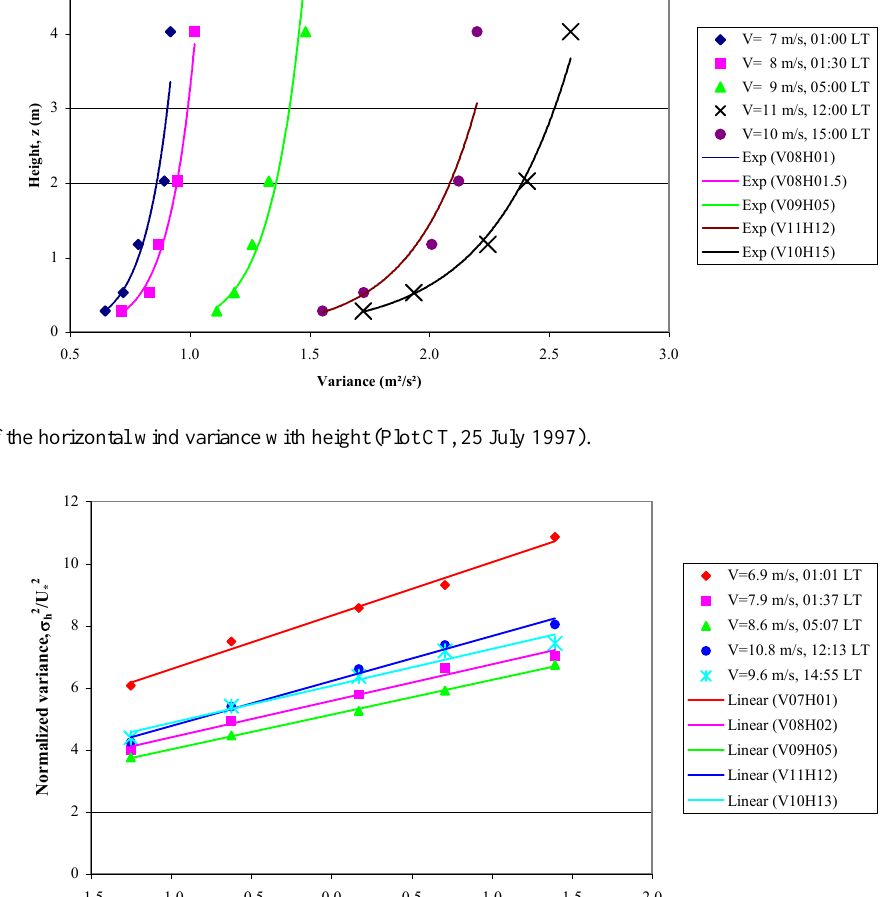
Figure 5: Variance normalized by the square of the friction velocity as a function of the Fig. 5. Variance normalized by the square of the friction velocity as a function of height logarithm (Plot RT, 25 July